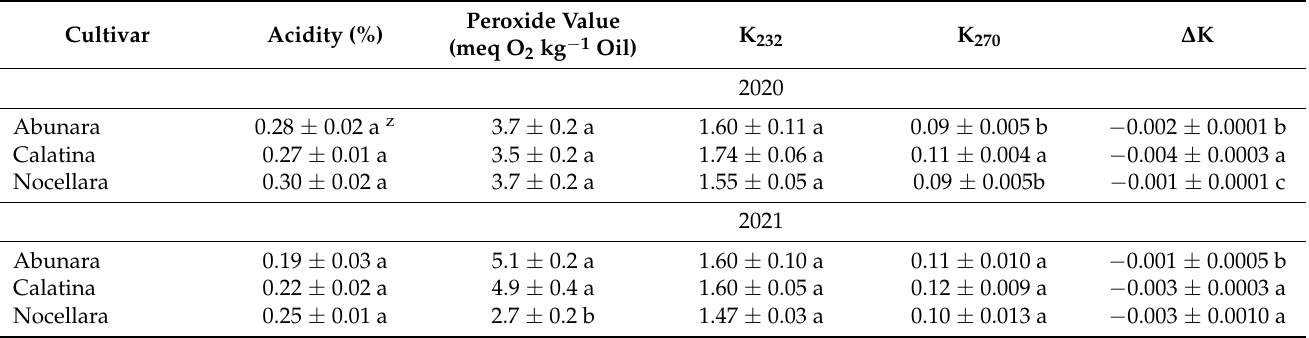
Table 2. Standard quality parameters of virgin olive oils from ‘Abunara’, ‘Calatina’, and ‘Nocellara del Belice’ olive trees grown as central leaders at 2 × 5 m (CLx2), free palmette at 3 × 5 m (FPx3), globe vase at 4 × 5 m (GVx4), and polyconic vase at 5 × 5 m (PVx5) in the last two years of trials. Data are expressed as means ± standard deviation (n = 12). For each cultivar, data from different planting systems were pooled together.